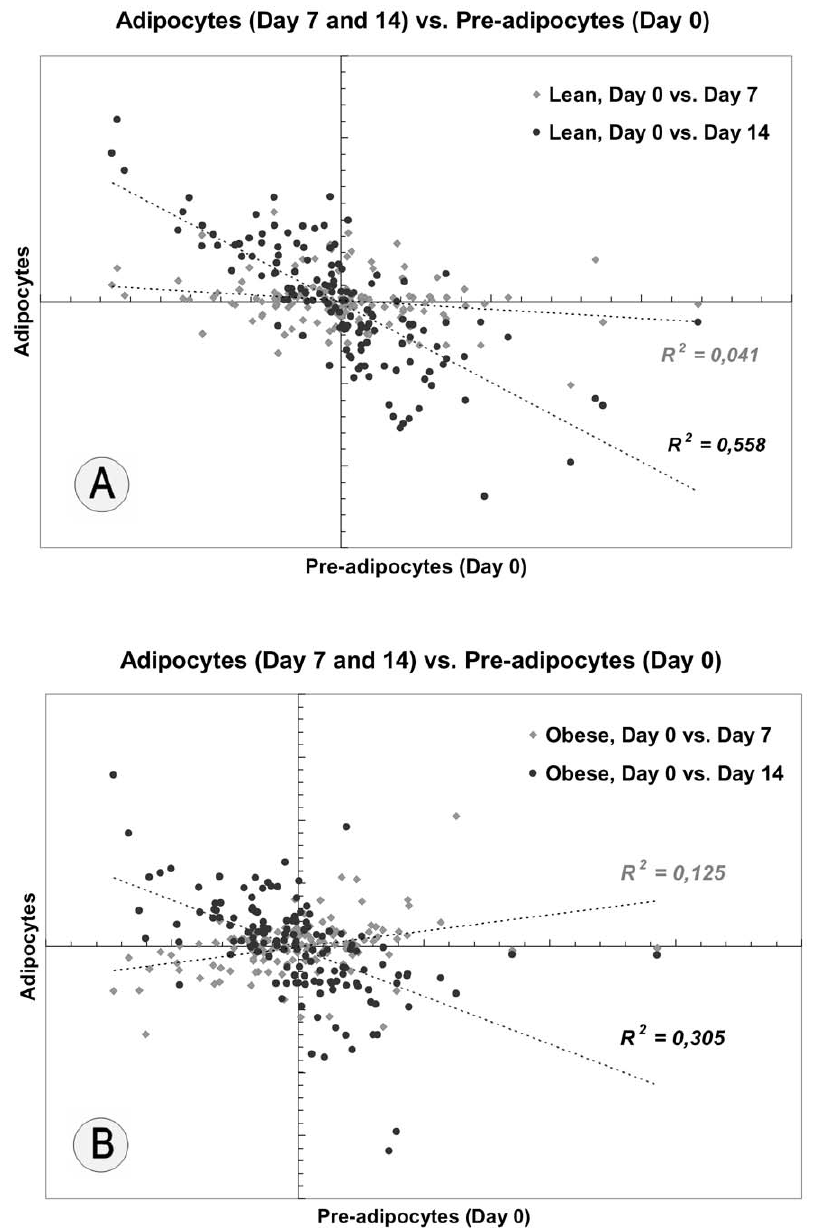
Figure 1. miRNA expression profiling during adipogenesis. Scatter plot showing comparison of miRNA expression profiles between undifferentiated human pre-adipocytes (Day 0) and adipocytes during differentiation at 7 th day (grey diamonds) or mature adipocytes at 14 th day (black circles) after inducing differentiation of stem-cells from subcutaneous fat depots of both lean (Fig. 1A) or obese (Fig. 1B) subjects.